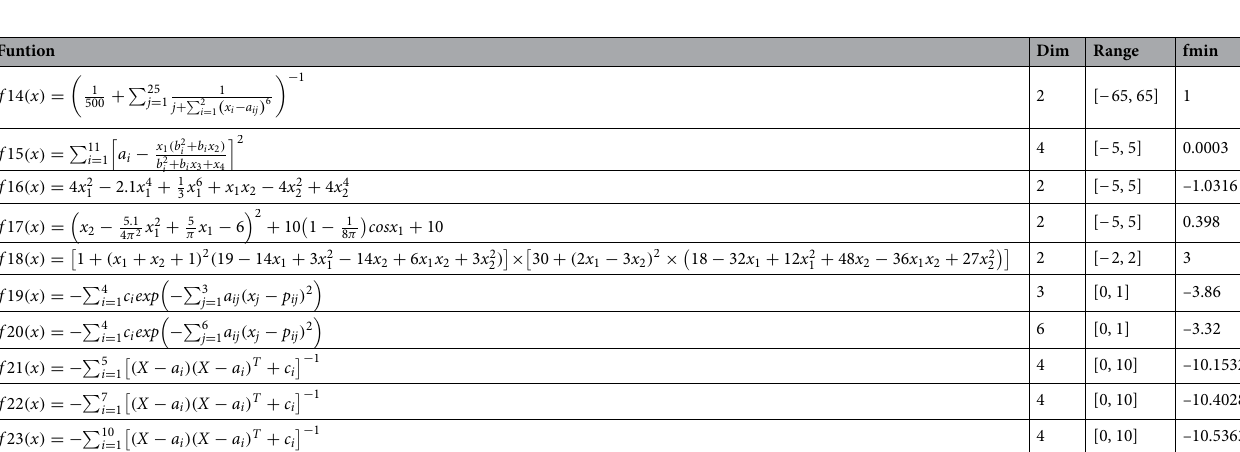
Table 4. Fixed-dimension multi-modal test functions.